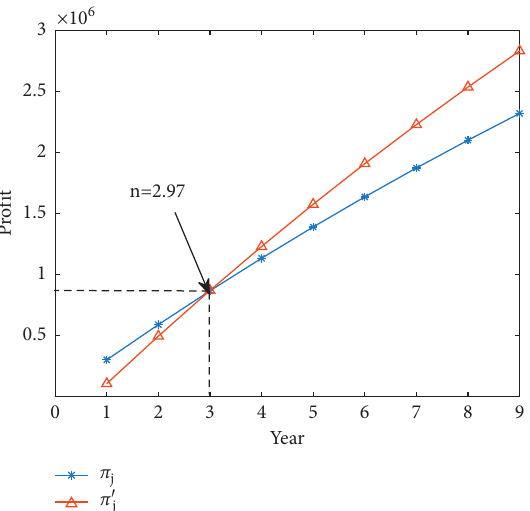
Figure 3: Profits of retailers with q